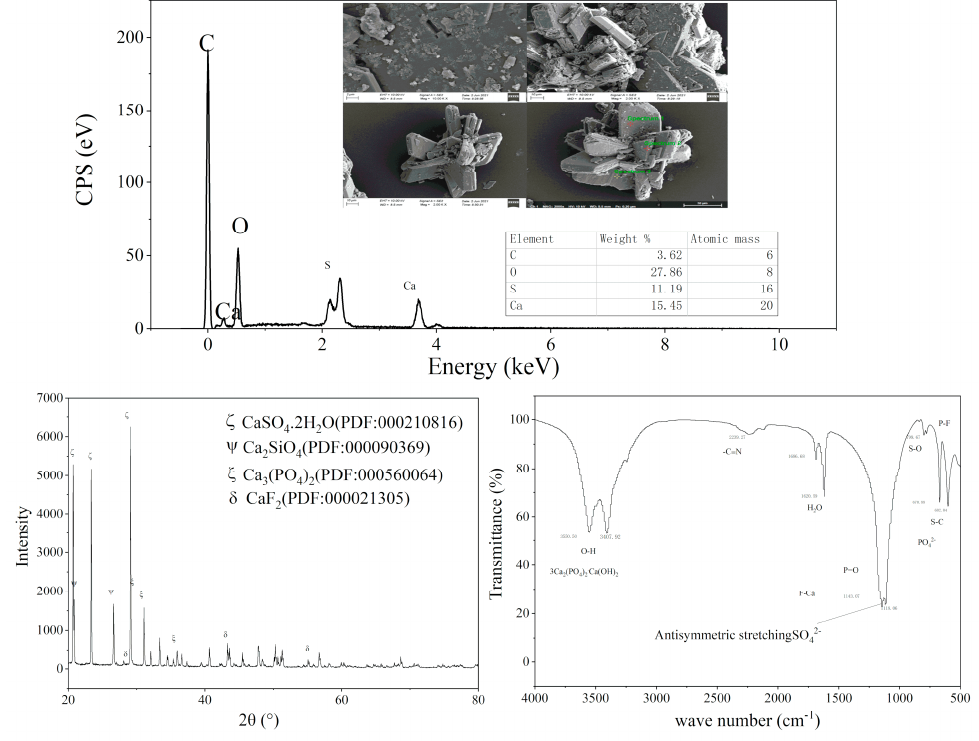
Figure 8. SEM-EDS, XRD and FTIR with addition of 1% CCS. As seen in the XRD characterization, the main component of PG is still CaSO 4 · 2H 2 O. Compared with PG, calcium silicate, orthophosphate, calcium fluoride and other new components appear when 1% CCS is added. The FTIR characterization further demonstrates the significant solidification of P and F in PG with a strong absorption peak at 1110 cm − 1 and a weak absorption peak at 600 cm − 1 , showing the symmetry and stretching peak of the phosphate ion. There are O-H vibration peaks in the wavelength range of 3400 to 3500 cm − 1 , which is caused by the O-H vibration in 3Ca 2 (PO4) 2 and Ca(OH) 2 , a weak F-Ca peak at 1140 cm − 1 indicate the formation of CaF 2 .